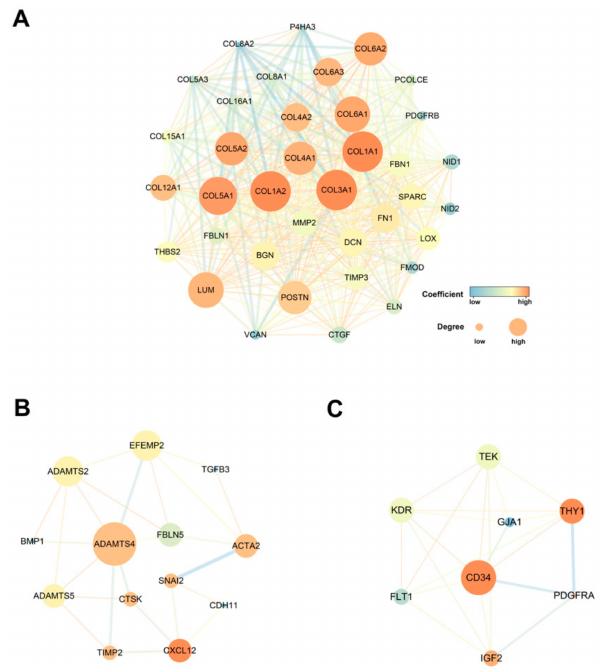
Figure 3. Top 3 modules of PPI networks: ( A ) COL1A1 module, ( B ) ADAMTS4 module and ( C ) CD34 module. The size of node in the PPI network reflects the number of interacting proteins with the certain protein, and the color scale indicates the clustering coe ffi cient value of the